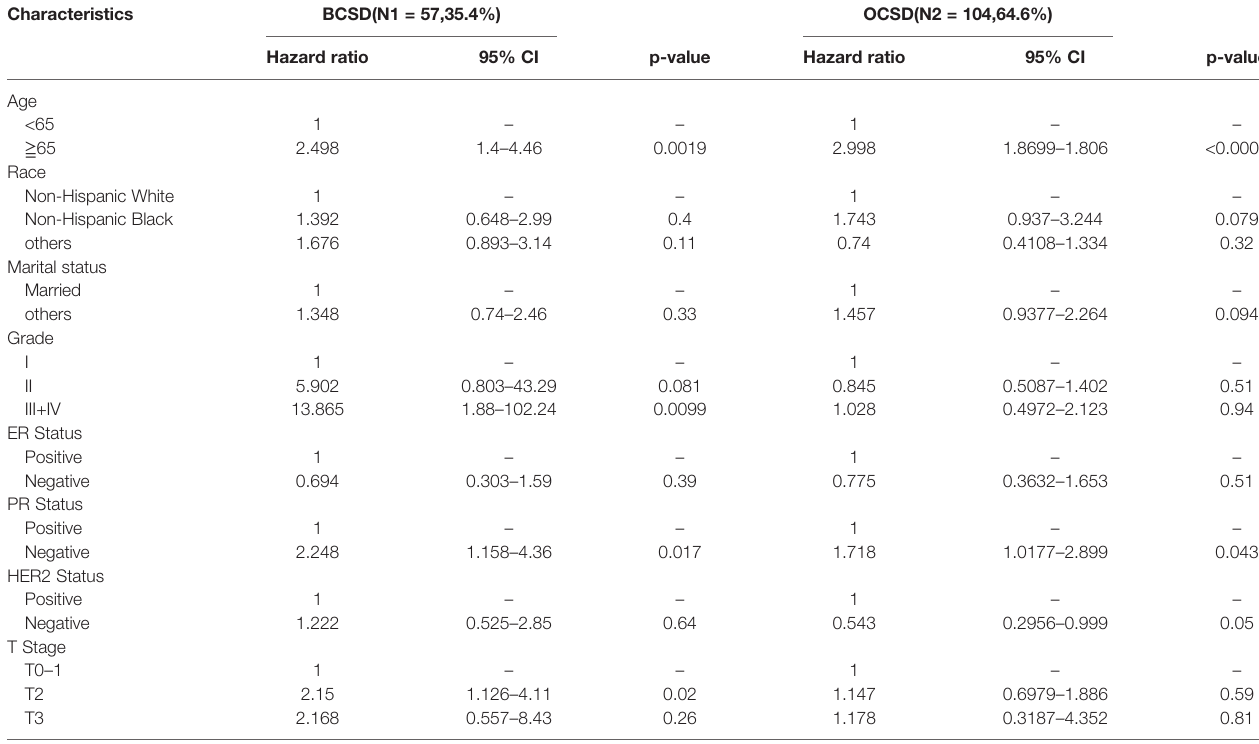
TABLE 4 | Multivariate competing risk regression model analysis for patients between 2010 and